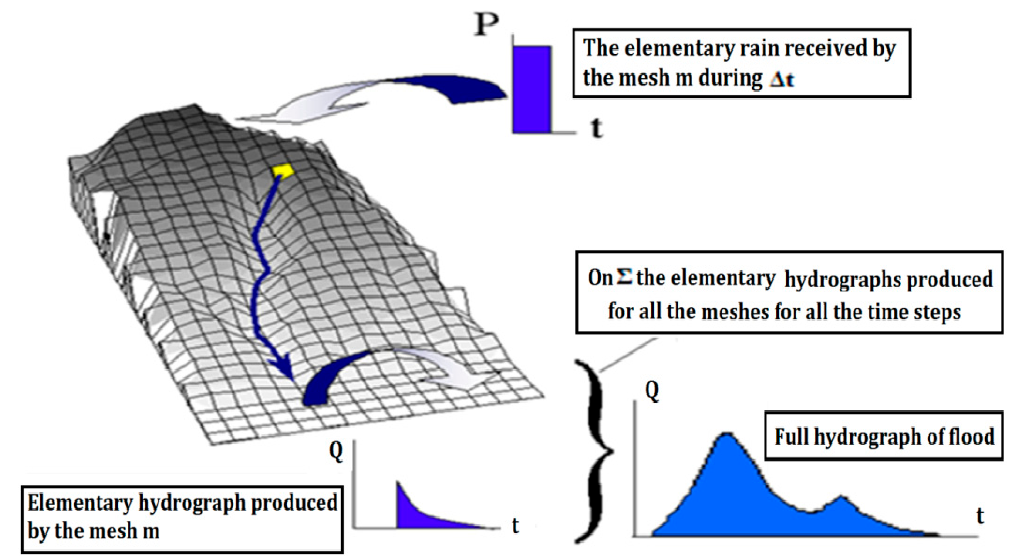
Figure 4. Functioning of the ATHYS model (www.athys-soft.org, accessed on 15 March 2022).